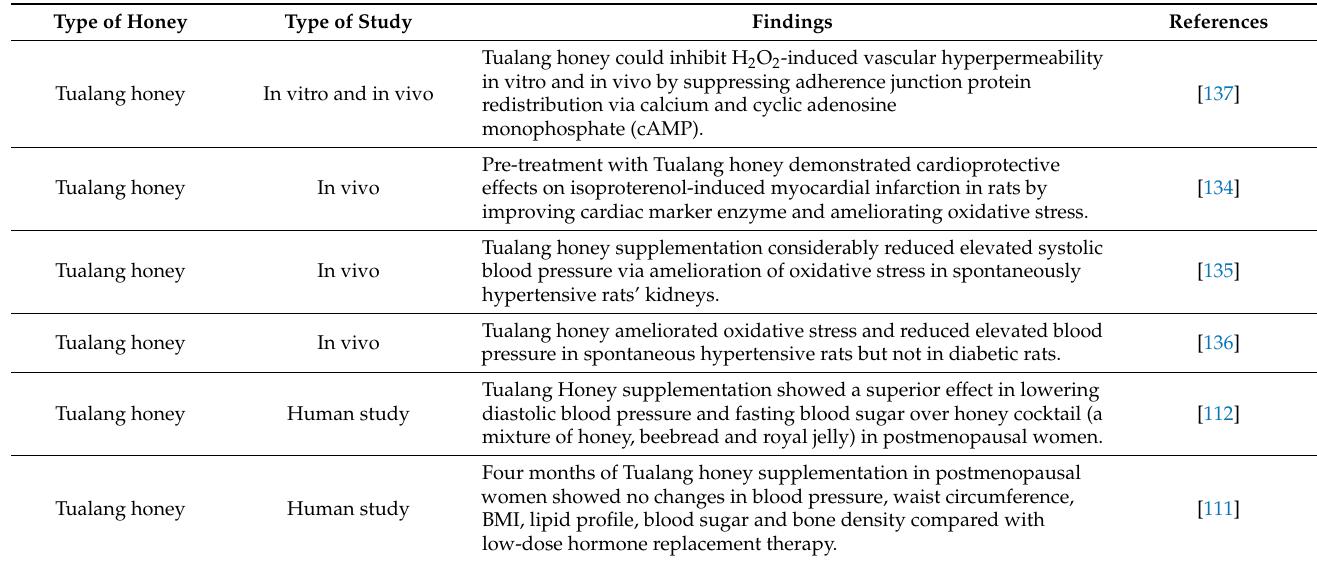
Table 10. Summary of the effects on cardiovascular